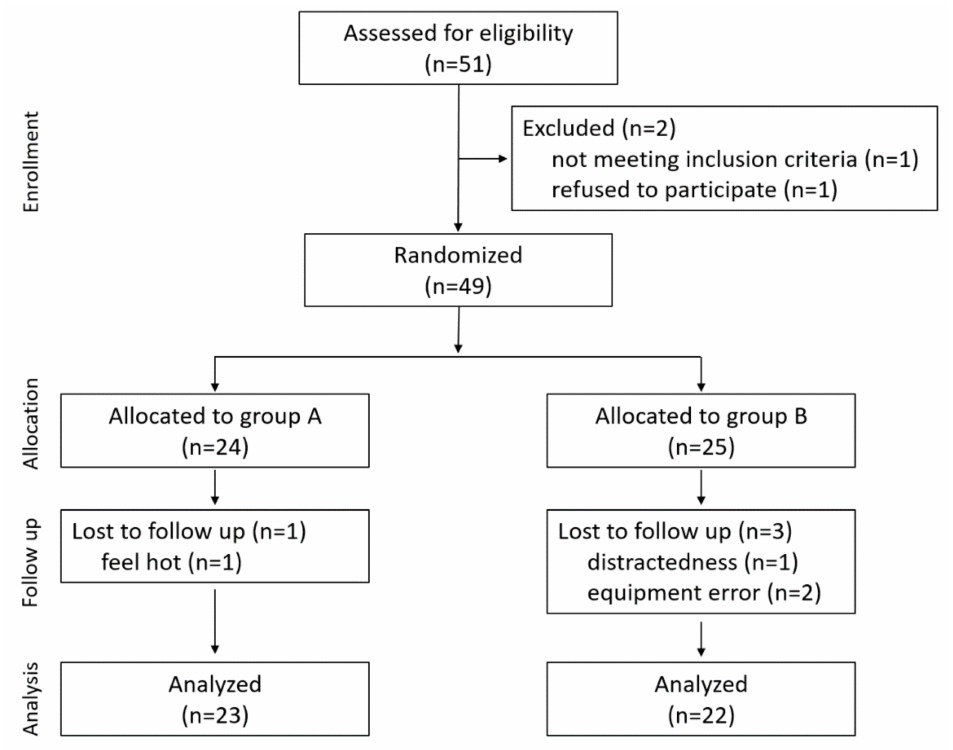
Figure 1. Participant flow